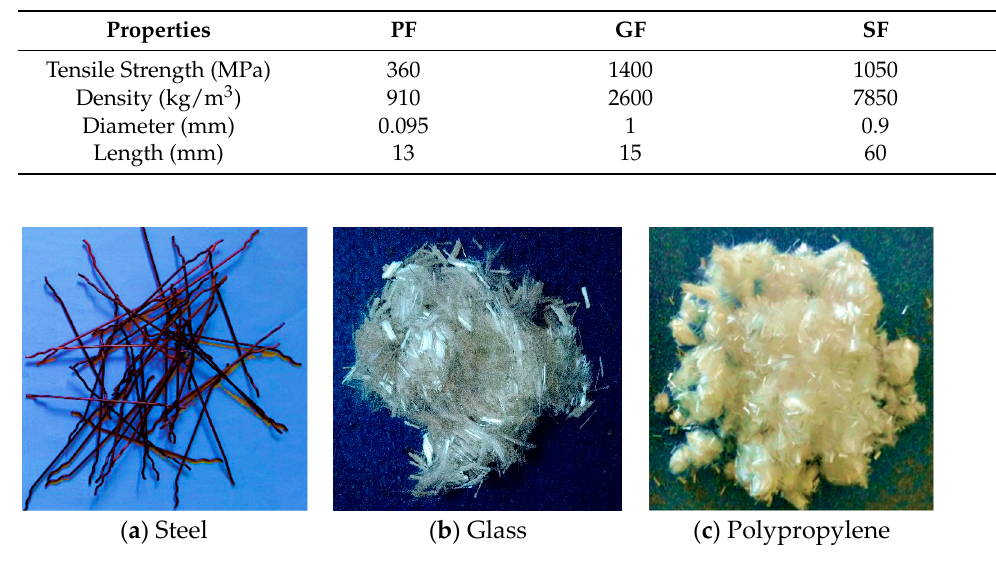
Figure 1. Appearance of fibers used in this study [27].